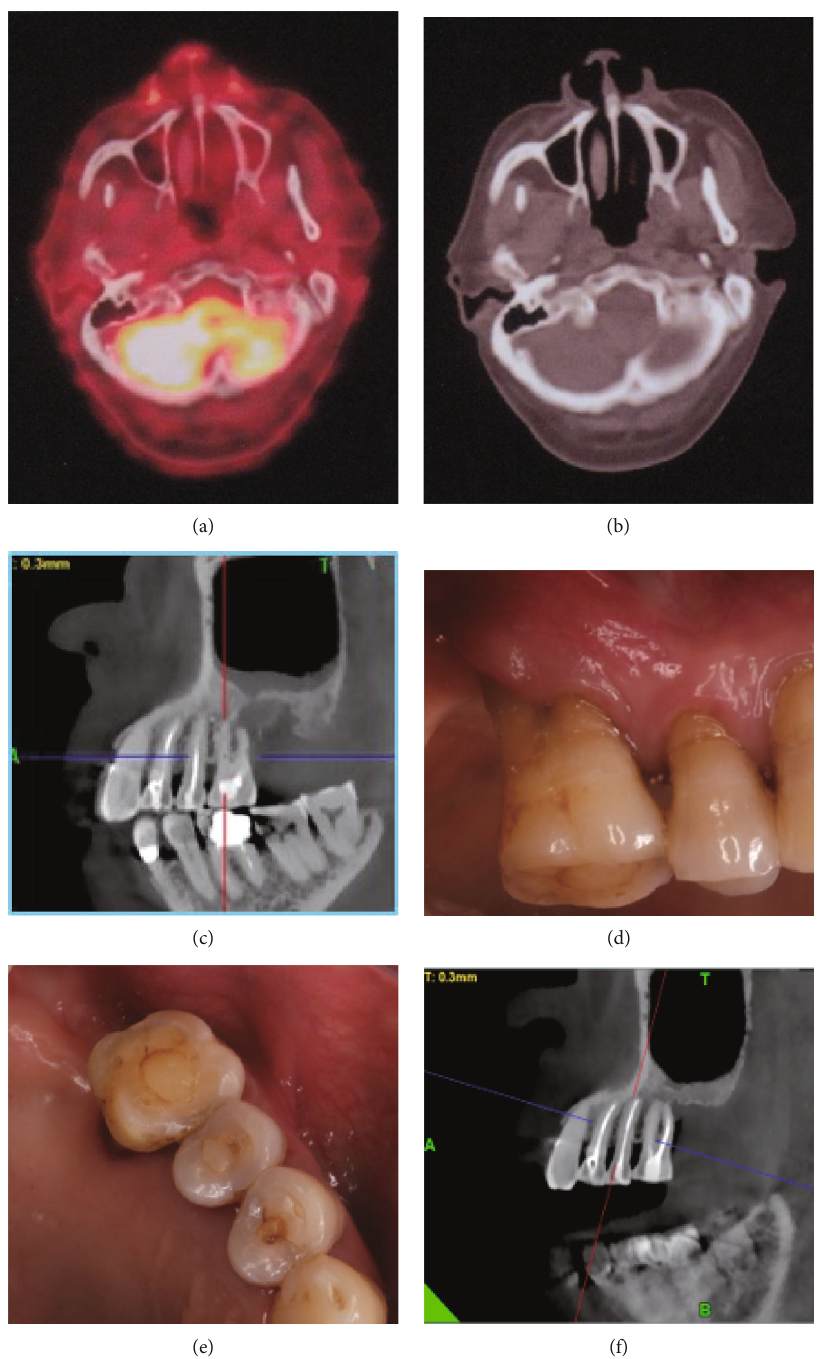
Figure 4: One month after the end of treatment, no distinct radioactive uptake in the left maxillary sinus was shown in transverse PET-CT images (a, b). CBCT image showed reduced substantial objects in the left maxillary sinus (c). Five years later, intraoral pictures showed healthy gingiva (d, e). CBCT showed that no substantial objects could be found in the left maxillary sinus